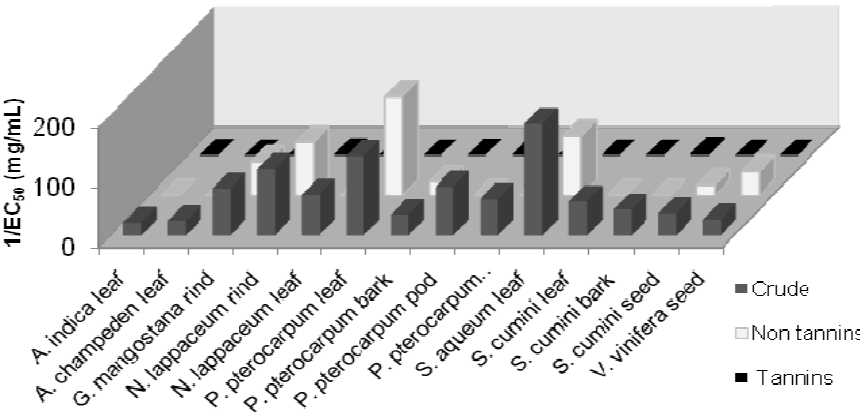
Figure 5.  -Amylase inhibition activity in the crude, non-tannin, and tannin extracts of various